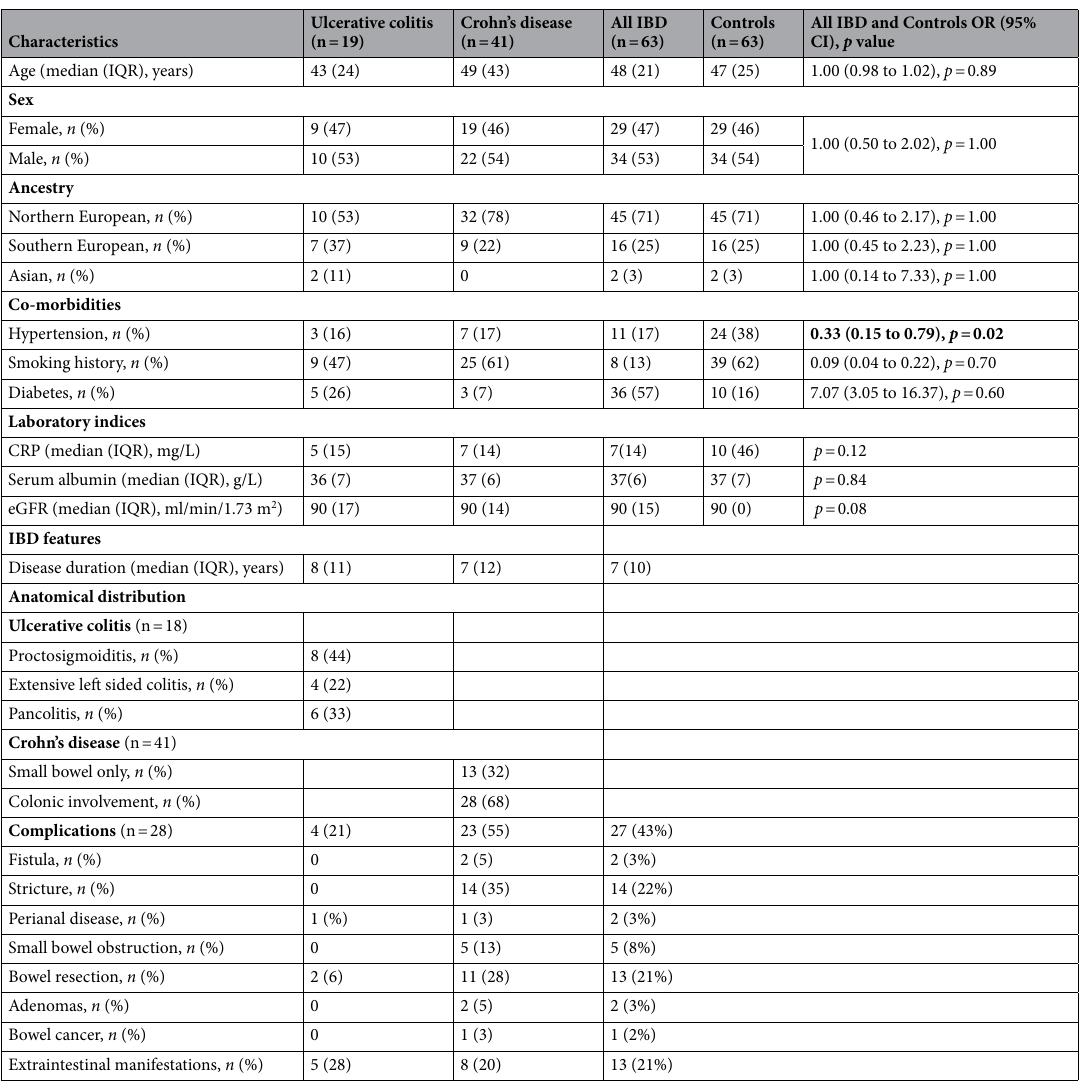
Table 1. Clinical characteristics of participants with IBD and controls. All IBD included participants with UC, CD or indeterminate disease; Anatomical distribution was not known in one individual with ulcerative colitis and five with Crohn’s disease. N/A not applicable. Significant values are in bold.